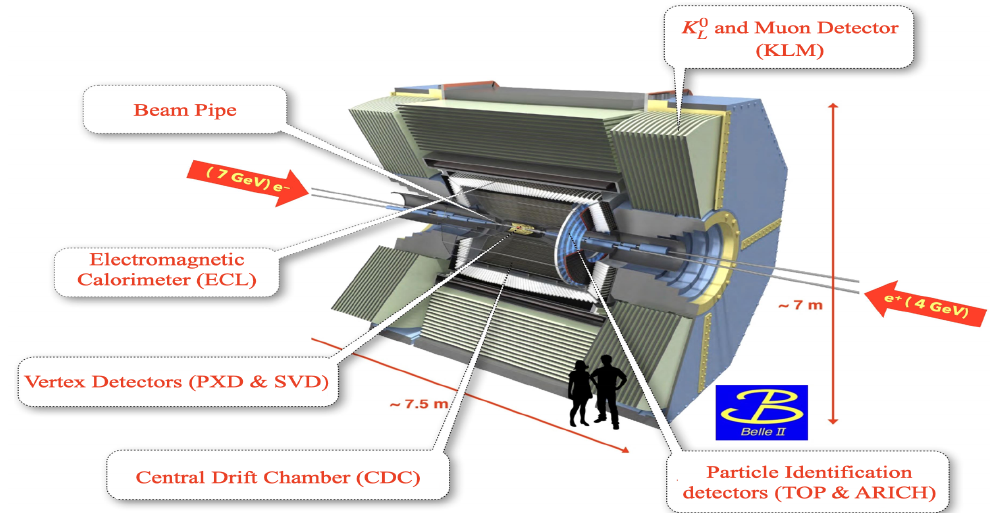
Figure 1. Schematic view of the Belle II detector [47]. The self-annotated figure is based on